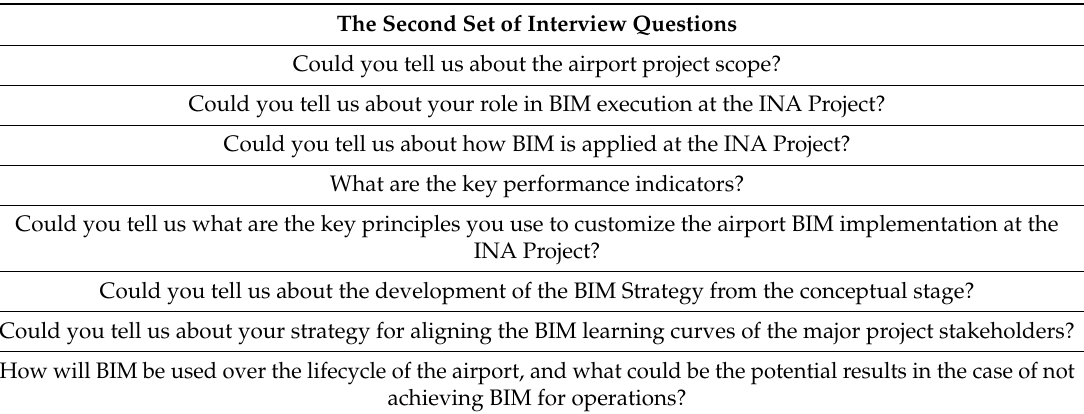
Table 4. The second set of interview questions.